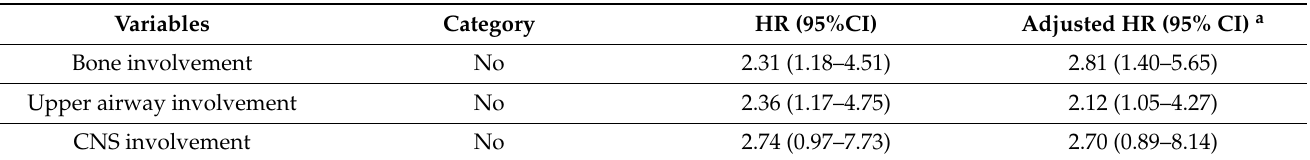
Table 4. Multiple Cox regression model of possible predictors to cure, of the patients with severe sporotrichosis treated with amphotericin B at the INI-Fiocruz between 1998 and